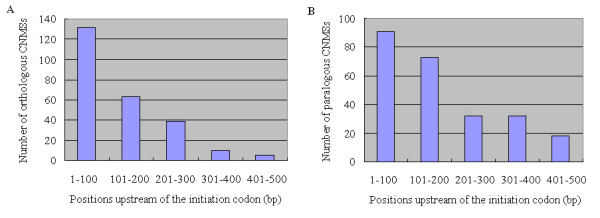
Distribution of (A) orthologous and (B) paralogous CNMSs in the 5' noncoding regions in Arabidopsis. The position is indicated as segments of 100 bp.